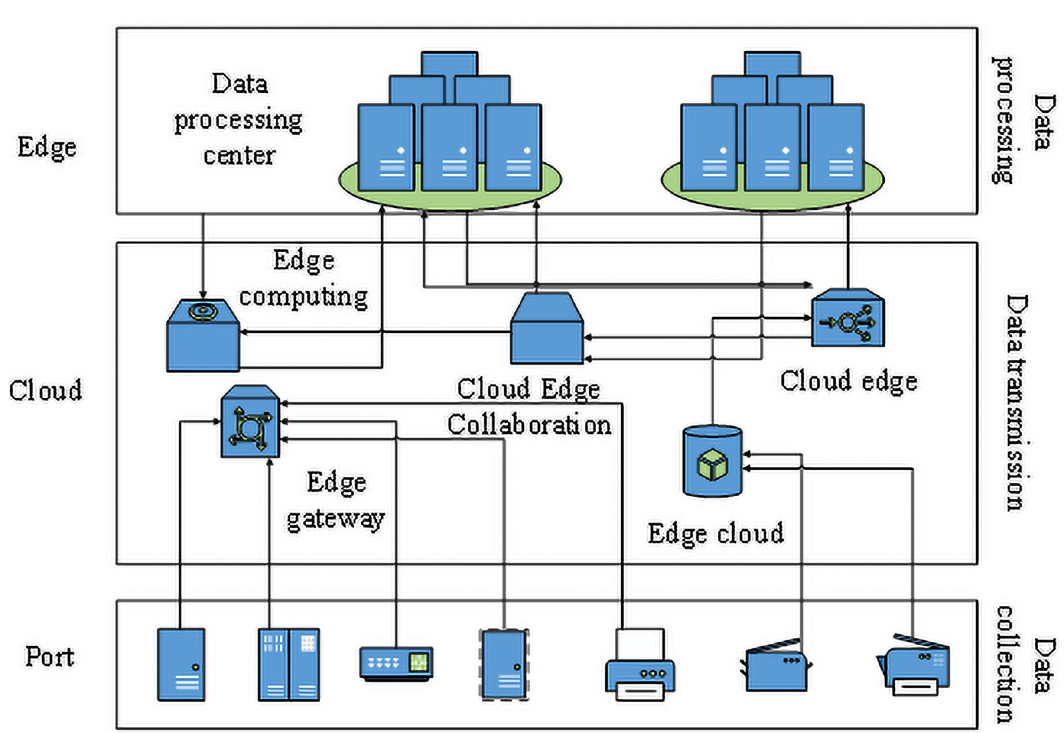
Fig 2. Architecture of the edge-cloud collaborative IoT data processing